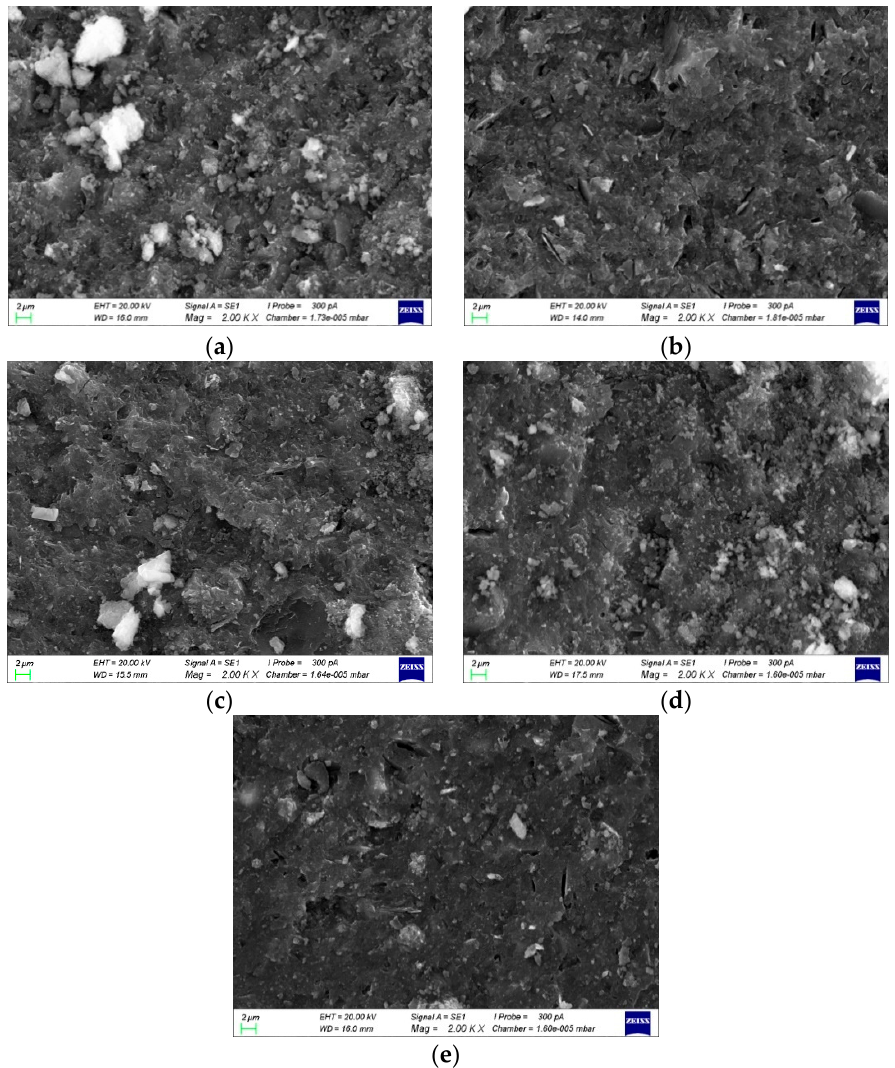
Figure 10. ( a ) The Si/Na ratio was 1.8 and the specimen was amplified 2000 times; ( b ) the Si/Na ratio was 1.9 and the specimen was amplified 2000 times; ( c ) the Si/Na ratio was 2.0 and the specimen was amplified 2000 times; ( d ) the Si/Na ratio was 2.1 and the specimen was amplified 2000 times; ( e ) the Si/Na ratio was 2.2 and the specimen was amplified 2000 times.